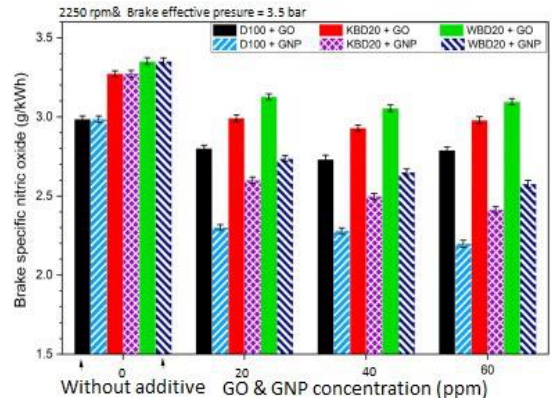
Fig. 11. Variation of NO x emission depending on the concentration GO [5]